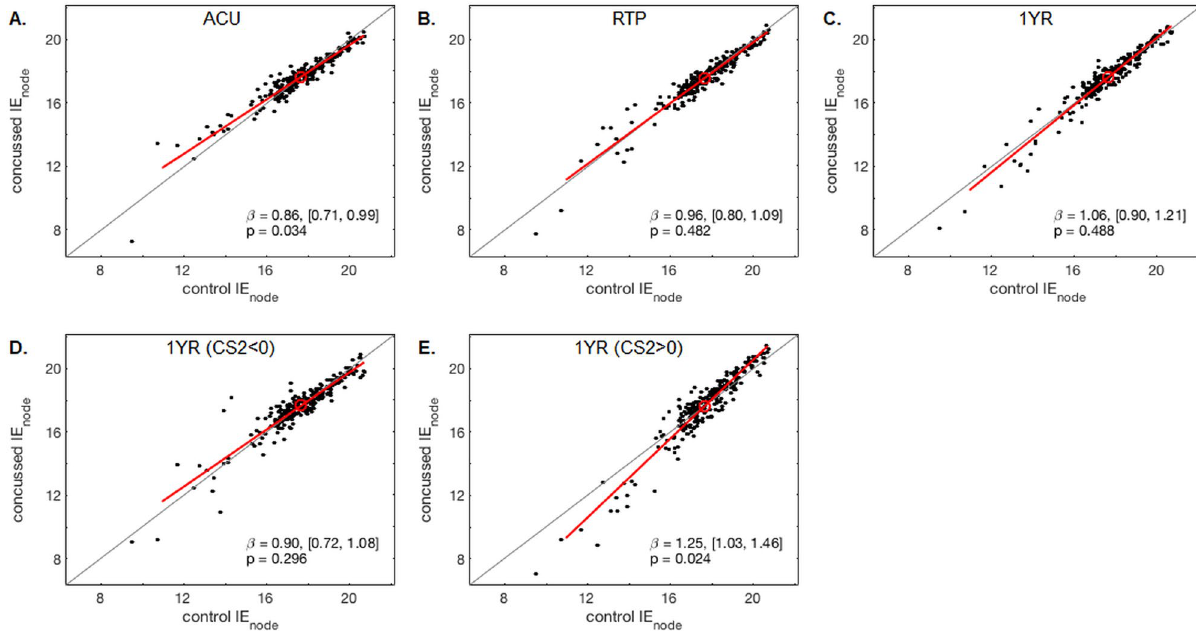
Figure 3. Effects of concussion on nodal efficiency distributions. Points in the scatterplots represent mean integrated nodal efficiency ( IE node ) values of concussed athletes, for a given node, plotted against the corresponding mean of athletic controls. The scatterplots are shown for ( A ) acute injury, ( B ) return to play (RTP) and ( C ) 1 year post-RTP. Additional scatterplots show mean IE node values of the concussed athletes at one year post-RTP, subgrouped on clinical score CS2 (days to RTP symptom severity), with ( D ) CS2 < 0 and ( E ) CS2 > 0. For all scatterplots, the line of best fit is given (red line) along with the nodal mean (red circle); the line of identity is also plotted (grey line). The slope coefficient β is also given, along with bootstrapped 95%CIs and empirical